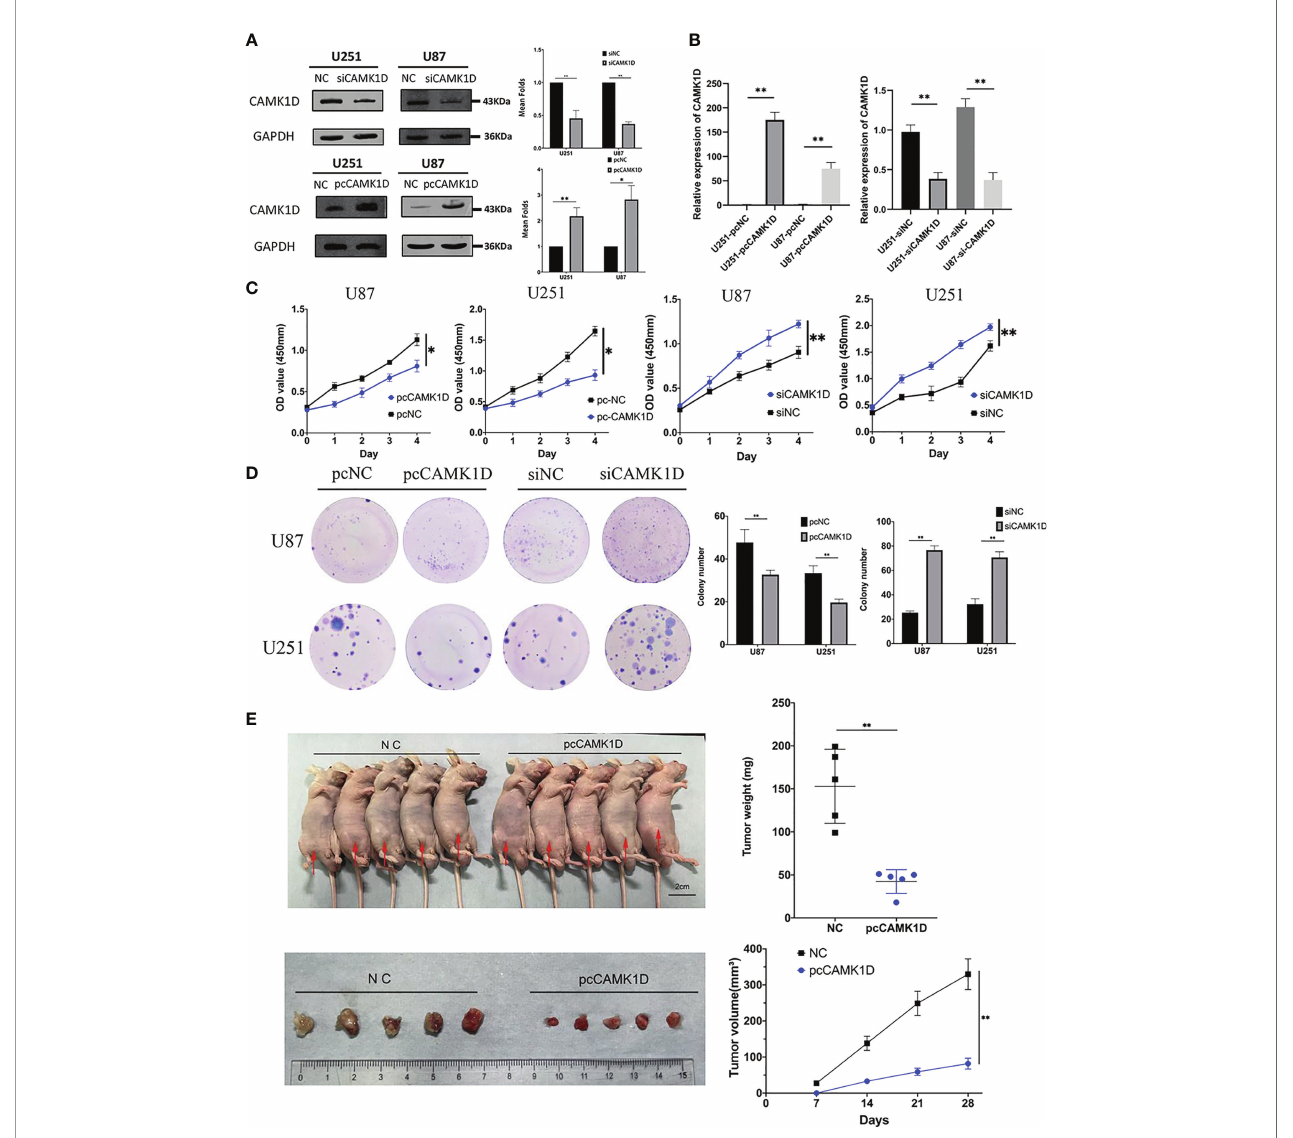
FIGURE 4 | CAMK1D inhibits glioma cell proliferation. (A, B) The protein and mRNA levels of CAMK1D were able to be downregulated and overexpressed in glioma cells by siCAMK1D and paCAMK1D. (C) CCK8 assays measured the effect of CAMK1D on the growth of glioma cells. (D) Colony formation assay used to verify the in fl uence of CAMK1D on glioma cell proliferation. (E) The tumor growth rate in vivo was inhibited after injection of U251 cells overexpressing CAMK1D. * p < 0.05; ** p <